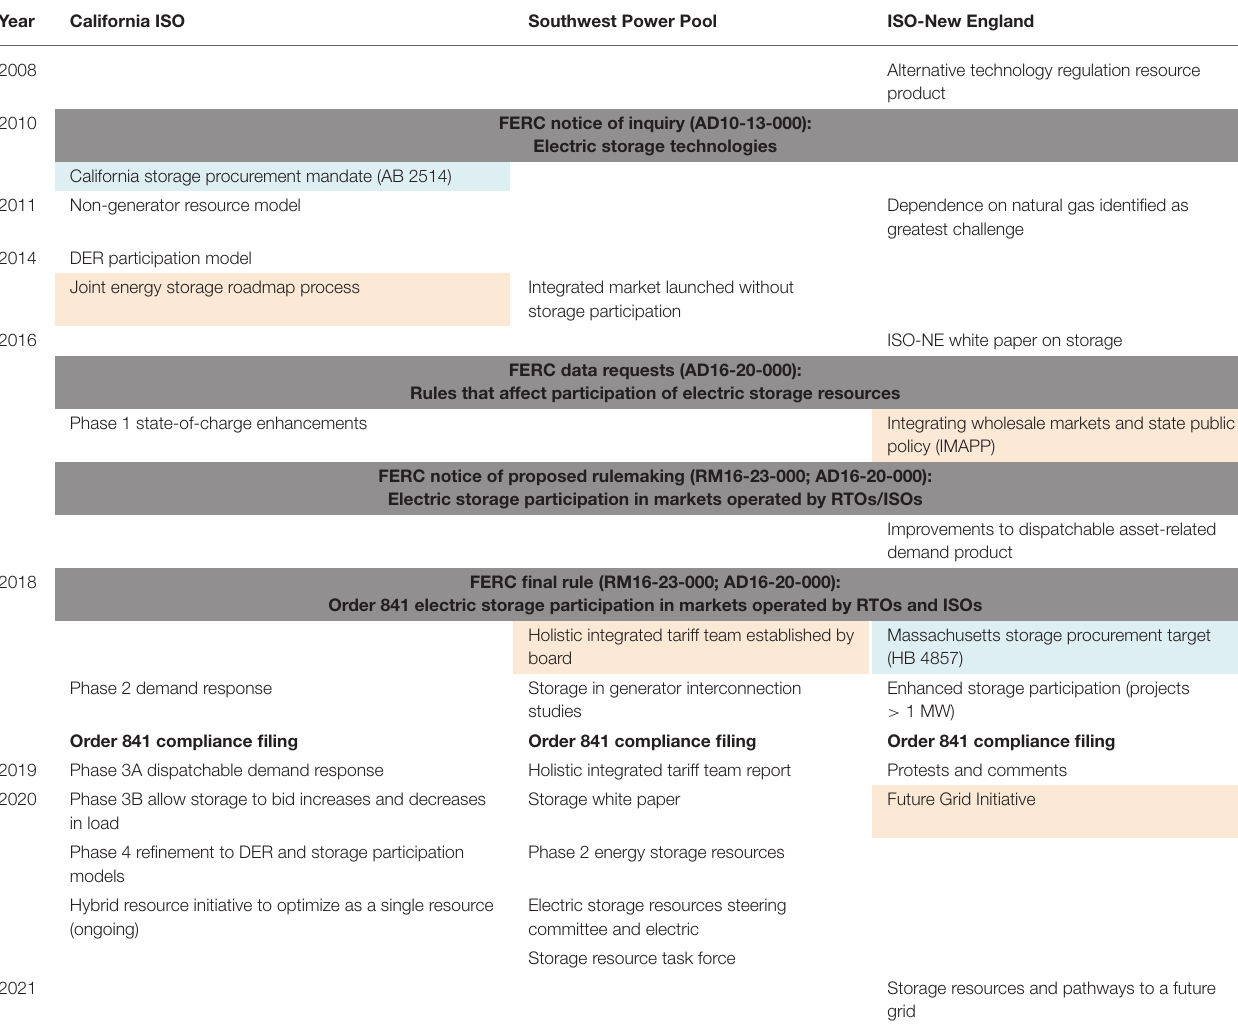
TABLE 3 | Timeline of FERC and RTO actions on electric storage resource market